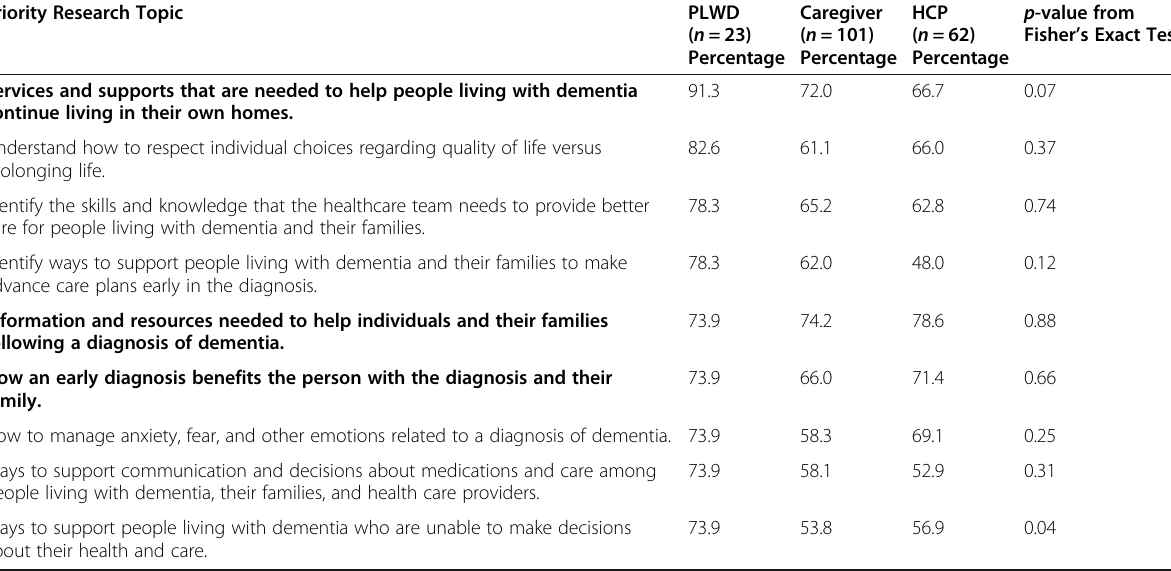
Table 4 Comparison of Top Priorities of PLWD with Rating as “ Very Important ” by Other Stakeholders Priority Research